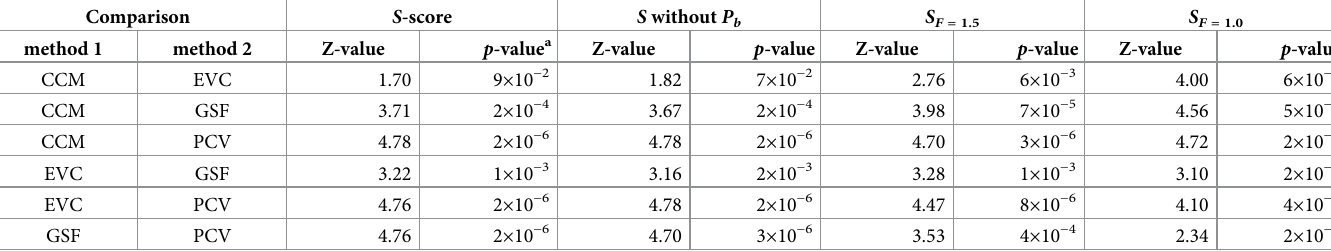
Table 3. Wilcoxon Signed Rank 2-tailed tests for the 30 analyses in Table